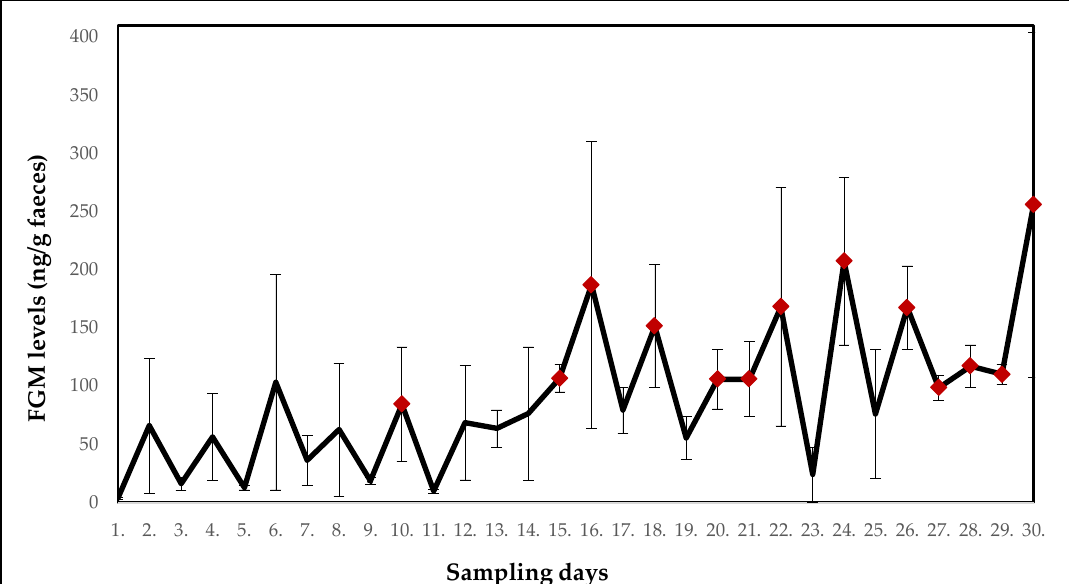
Figure 3. Mean concentrations of the faecal glucocorticoid metabolites (FGMs) in white-headed lemurs; significant increases compared to the first day of sampling are indicated. Red points indicate a significant increase in FGM levels.